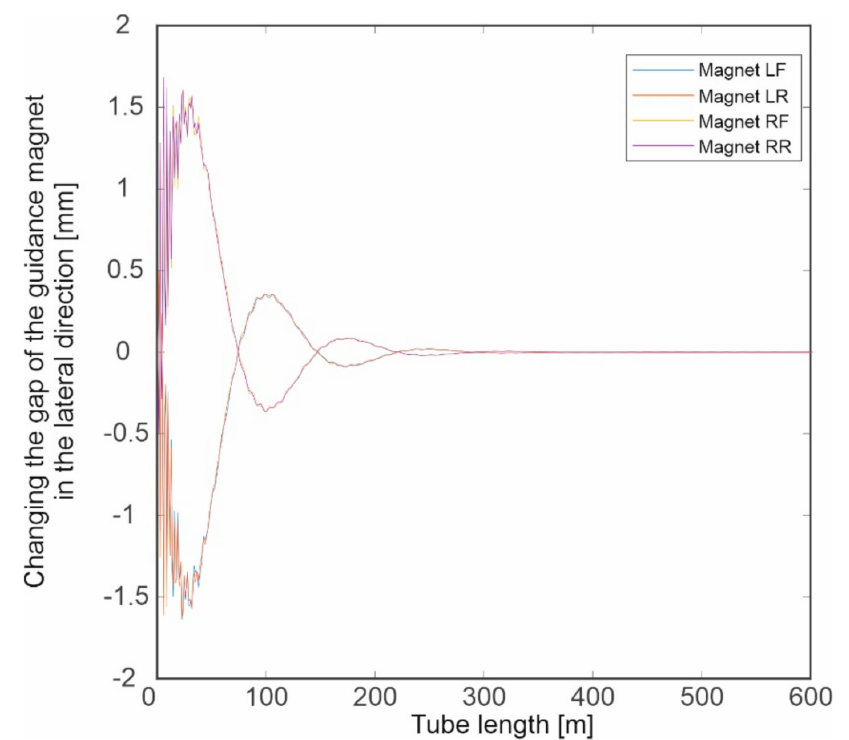
Figure 8. Change in the gap width on the guidance magnet in the lateral direction resulting from the capsule speed of 1000 km / h.